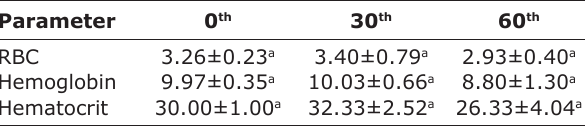
Table-10: The average amplitude and duration of R wave of the pigs.